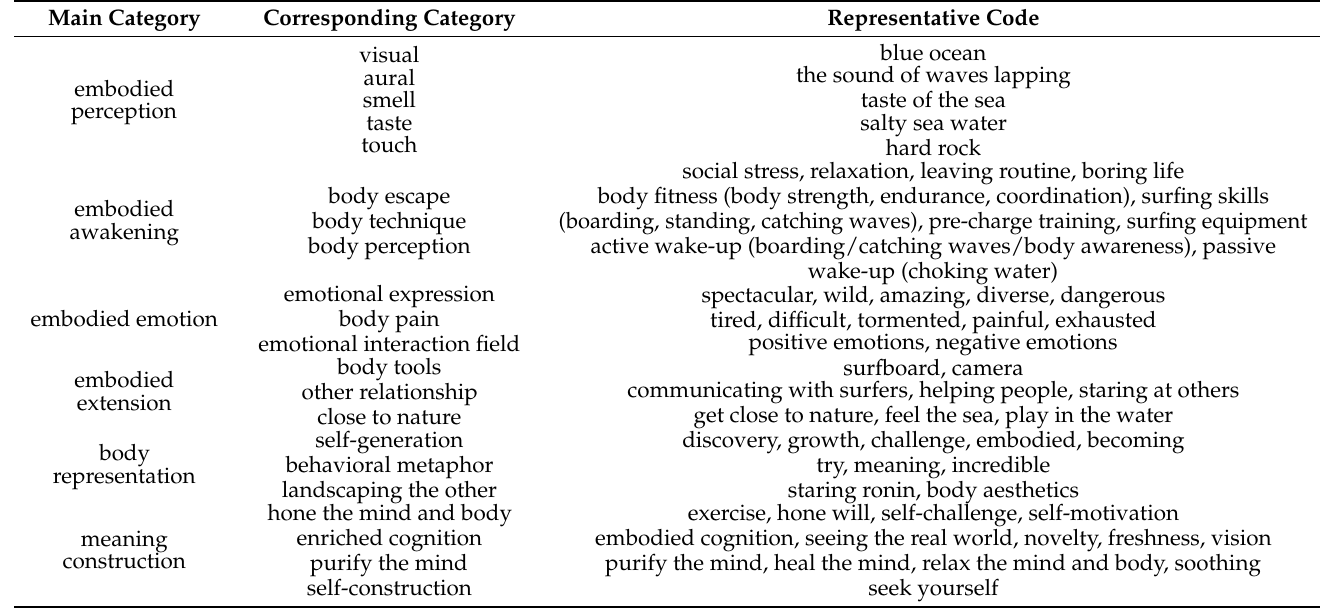
Table 3. Main categories formed by axial coding.